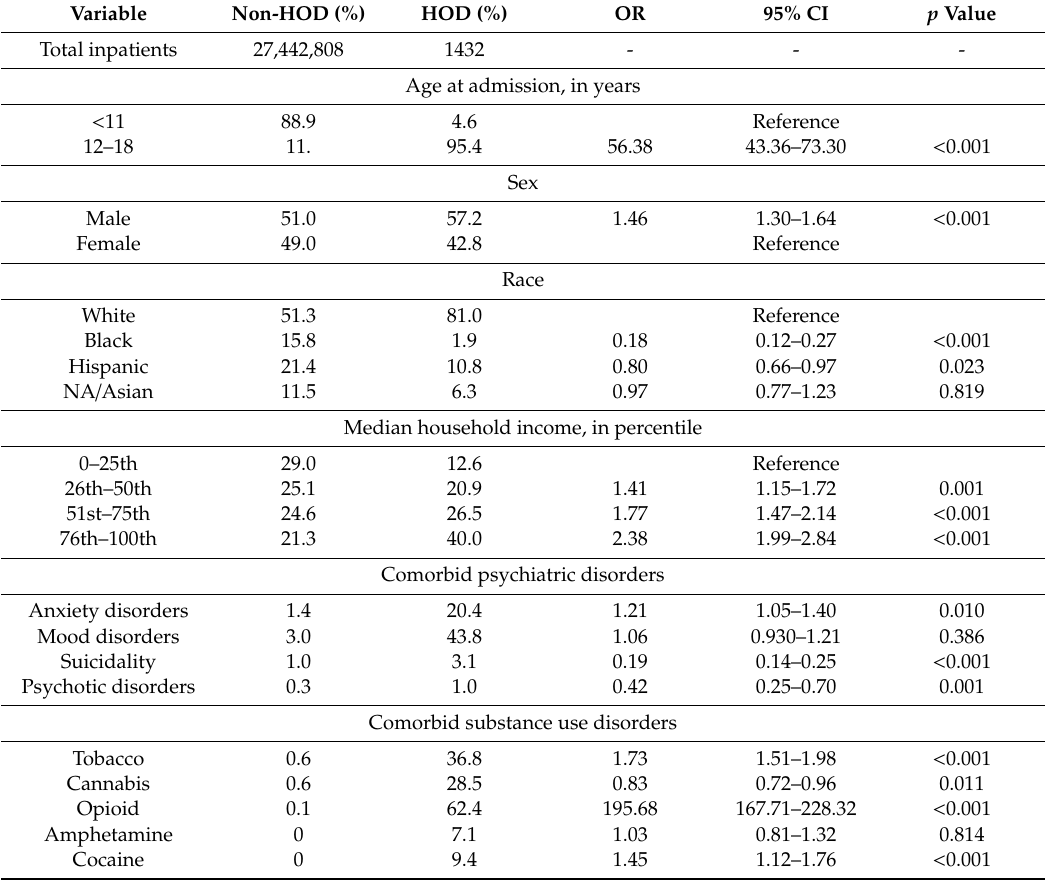
Table 1. Suspected risk factors for heroin opioid overdose-related